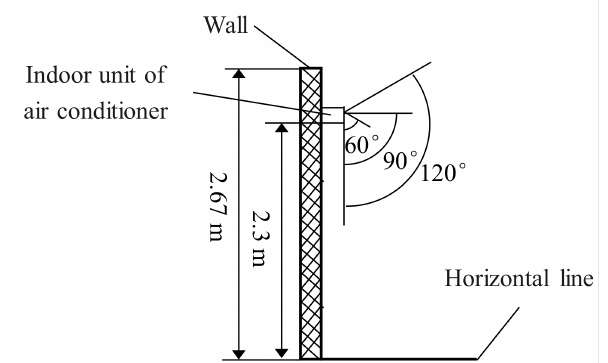
Figure 10. Air supply angle of indoor unit.